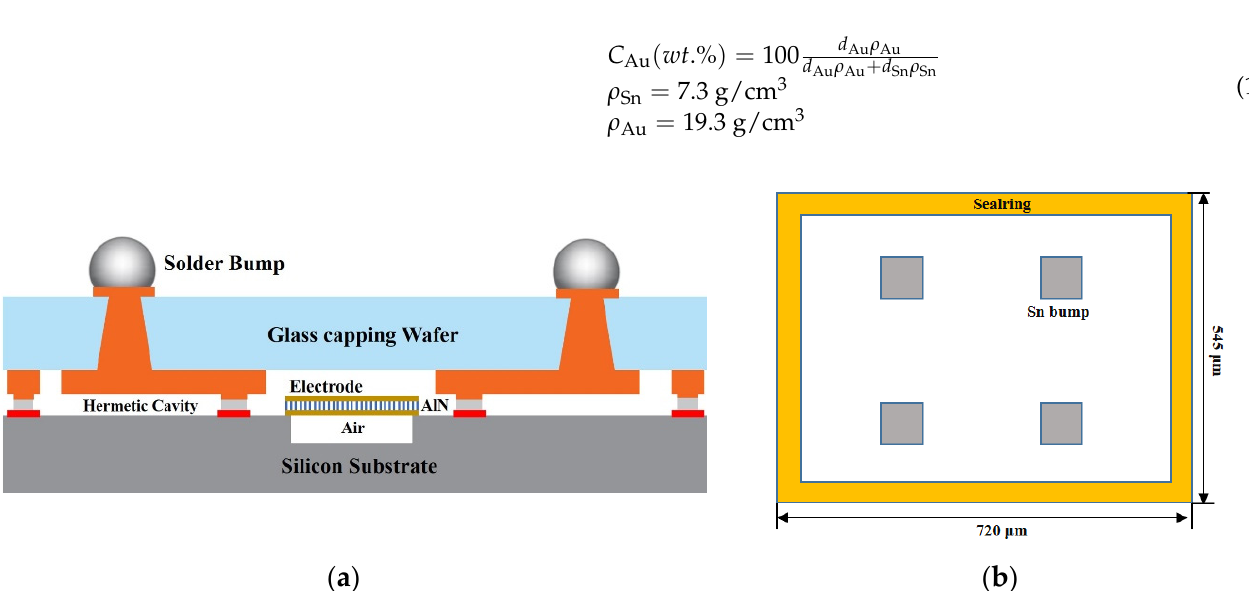
( b ) Figure 1. ( a ) Schematic structure of AlN RF filter WLP. ( b ) Top view of the capping wafer. 2.2. Optimization of the Bonding Structure and Bonding Parameters 2.2.1. Optimization of the Thickness of the Sn and Ni Layer As the bonding process is fluxless, systematic experimental work has been carried out to study the effect of thickness of the Sn layer in the seal ring and bump metallization on the reliability of the RF filter package. Firstly, too thick seal ring closed square will result in molten Sn overflow from the edge into the die area, which will result in a short circuit. Conversely, a too-thin Sn layer will cause poor wetting, affecting the bonding strength. Fig- ure 2 shows the cuboid micro-joint, the effective Au concentration, set at 1.5 μ m, and all Au atoms are dissolved in the solder, which can be calculated by Equation (1) [29].